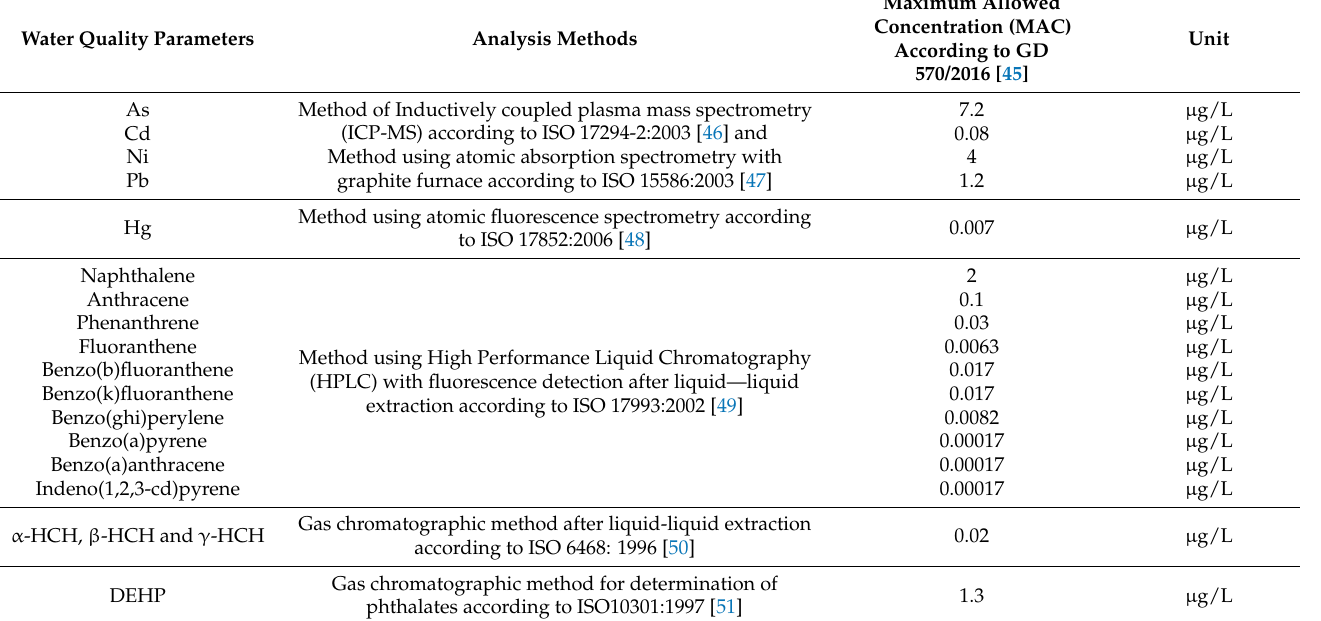
Table 2. The priority pollutants analyzed, associated methods, and maximum allowed concentra- tions